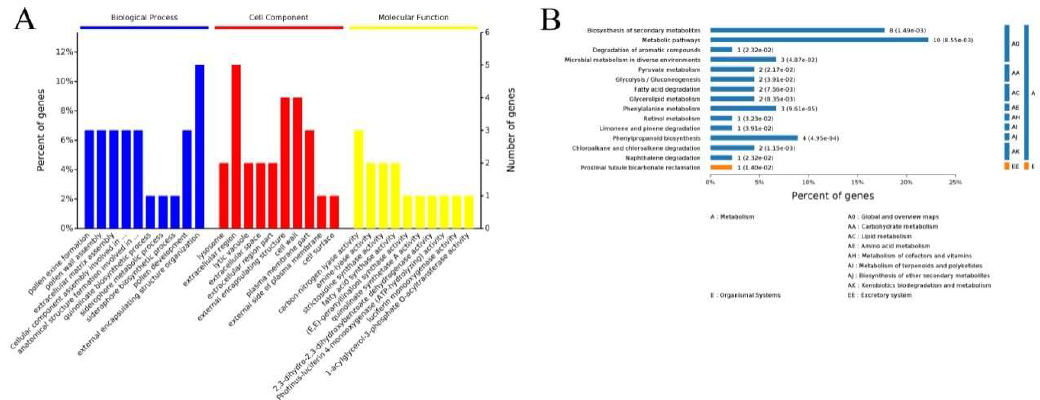
Figure 5. Gene ontology (GO) and Kyoto Encyclopedia of Genes and Genomes (KEGG) enrichment analysis of cor-DEGs-DEPs genes. ( A ) GO functional enrichment analysis of cor-DEGs-DEPs genes. ( B ) KEGG enrichment analysis of cor-DEGs-DEPs genes.